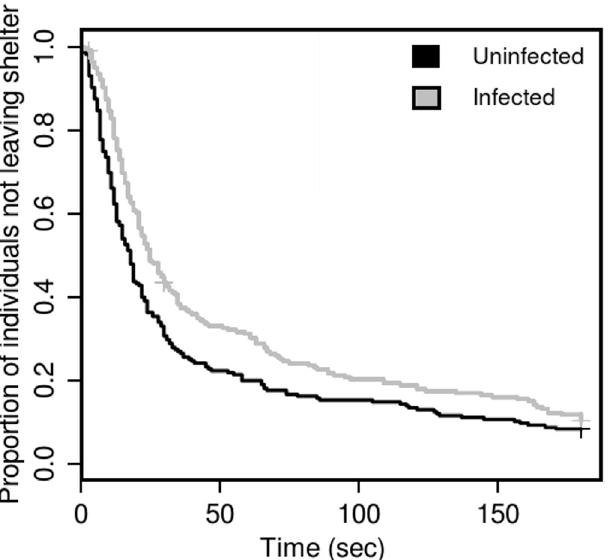
Figure 3. Time latency until leaving shelter in case of uninfected (N=215) and infected (N=215) workers.